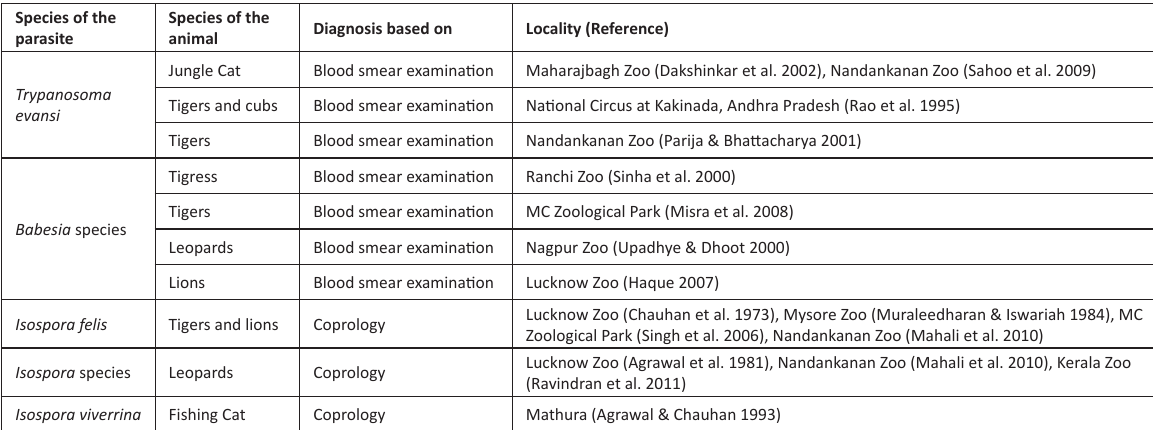
Table 6. Reports of protozoan parasitic infection of wild felids Species of the